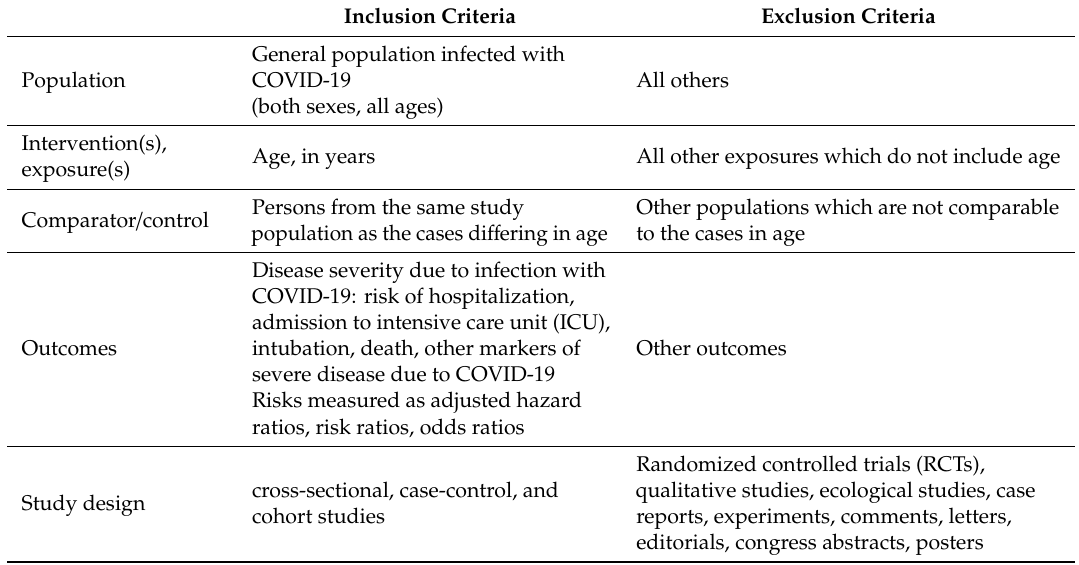
Table 1. Study eligibility